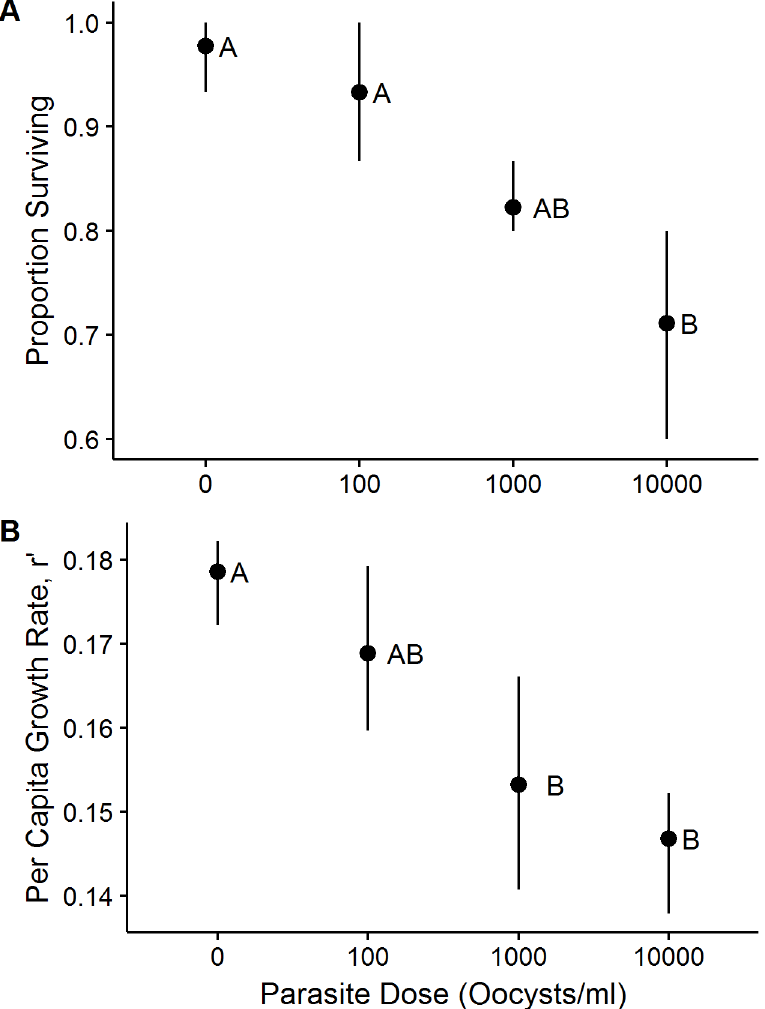
Fig 1. The mean proportionof mosquitoessurviving to adulthood(A) and mosquitoper capita rate of increase(B) exposedto different parasite dosages.Host Aedes albopictus fitness declinesby two measures as dosage of Ascogregarina taiwanensis increases.Different letters within each plot are significantly different basedon Tukey’s HSD. Whiskers are bootstrapped95% confidenceintervals (1000 replicates).